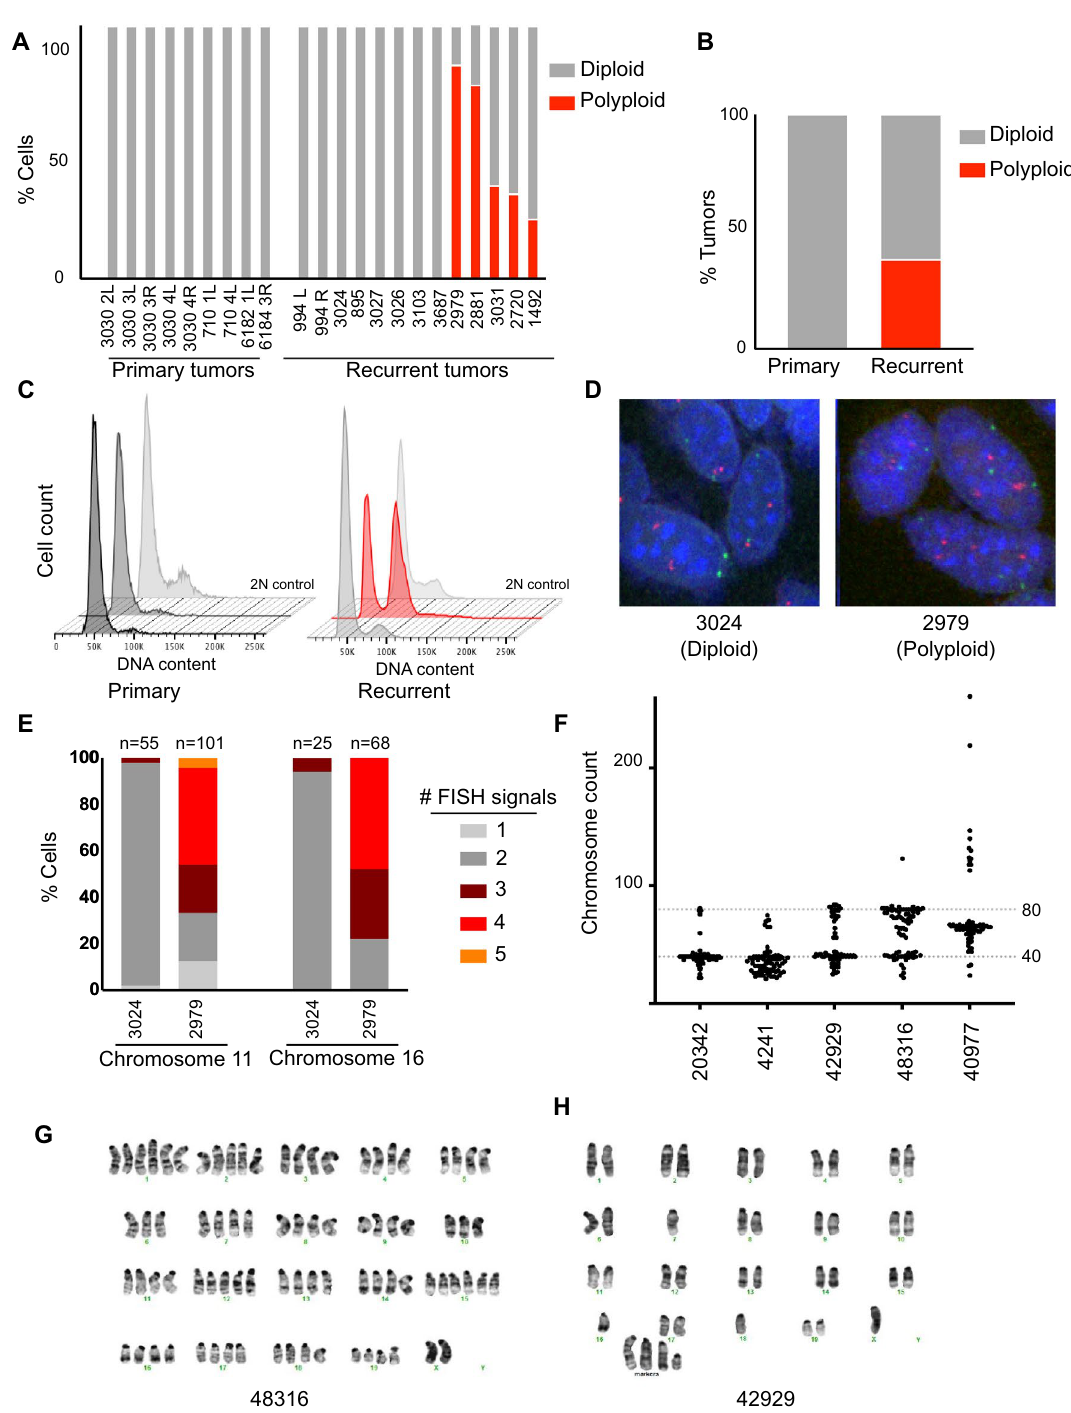
Figure 1. Tumor recurrence is associated with alterations in tumor cell ploidy. ( A ) Quantification of DNA content staining to determine the ploidy of primary (n = 9) and recurrent (n = 13) tumors derived from MTB;TAN mice. The percentage of near-diploid and near-tetraploid cells in each tumor was estimated using cell cycle modeling. ( B ) The frequency of whole-genome duplication in primary and recurrent tumors. ( C ) DNA content staining of representative primary and recurrent tumors. A diploid cell line is shown as a control. Figure was generated using FlowJo (FlowJo Software for Mac, Version 10.7.2. Becton, Dickinson and Company; 2020). ( D ) Representative FISH images for chromosome 2 (red) and 11 (green) on a diploid and polyploid tumor. ( E ) FISH using probes targeting chromosome 2 and 16 on a diploid tumor and a polyploid tumor. The number of FISH signals per cell was scored. ( F ) Chromosome counts from metaphase spreads of cells cultured from recurrent tumors arising in MTB;TAN mice. ( G ) and ( H ) Representative karyotypes of cells cultured from recurrent tumors. ( A – C ) and ( E – G ) were generated using Graph Pad Prism 9 software (version 9.0.0 (86) for Mac, https:// www. graph pad. com/ scien tific- softw are/